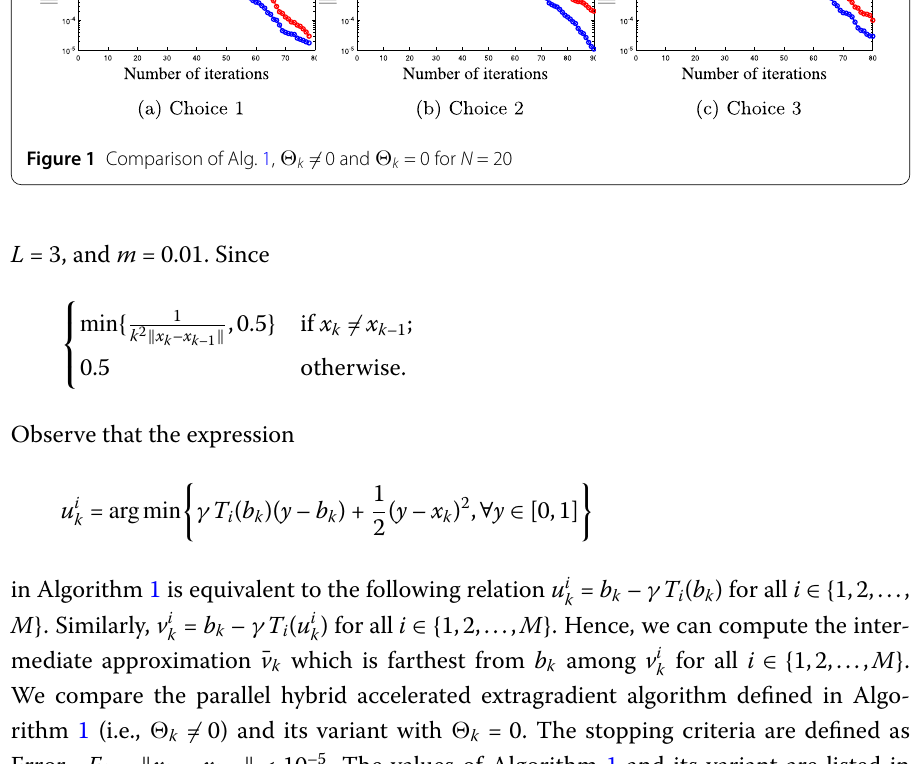
Table 1. The error plotting E k and ( x k ) of Algorithm 1 with (cid:8) k (cid:9) = 0 and (cid:8) k = 0 for each choice in Table 1 is illustrated in Fig.